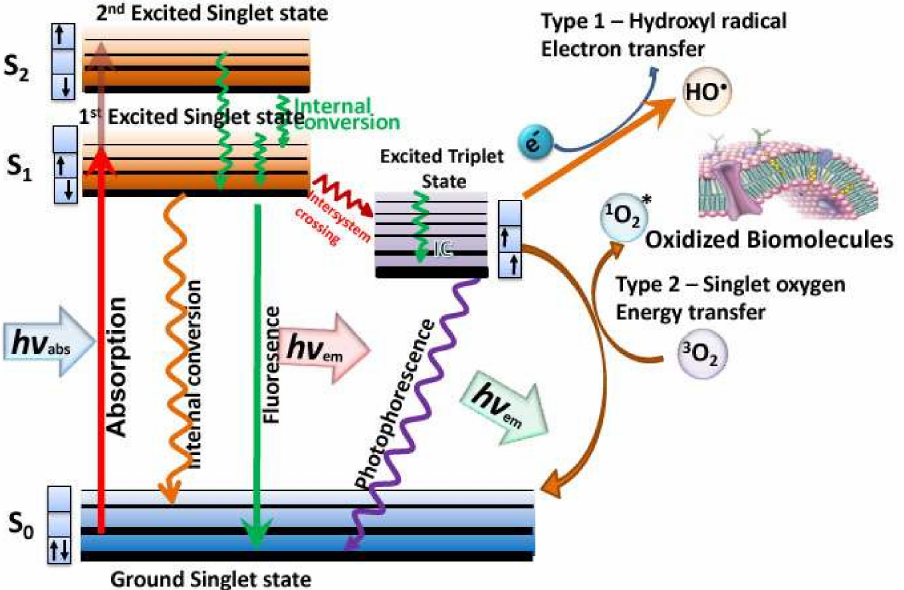
Figure 1. Jablonski diagram showing the photochemical mechanisms operating in antimicrobial photodynamic inactivation